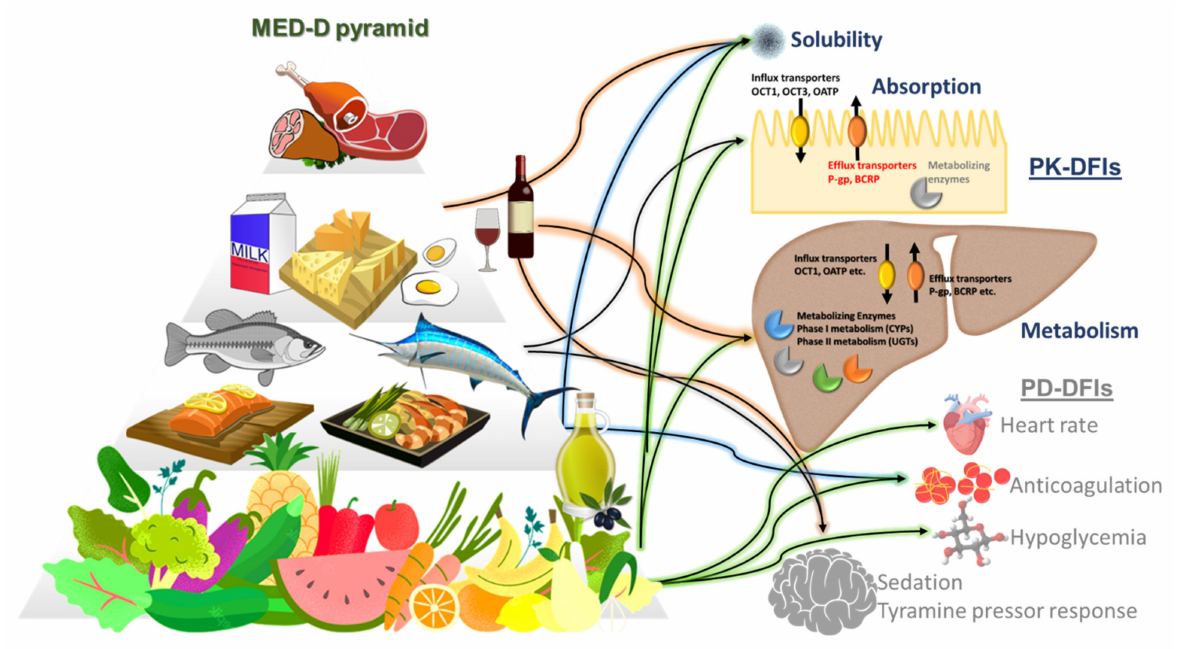
Figure 5. DFIs of Med-D food products regarding relation with type II and type III (subtypes a and b)